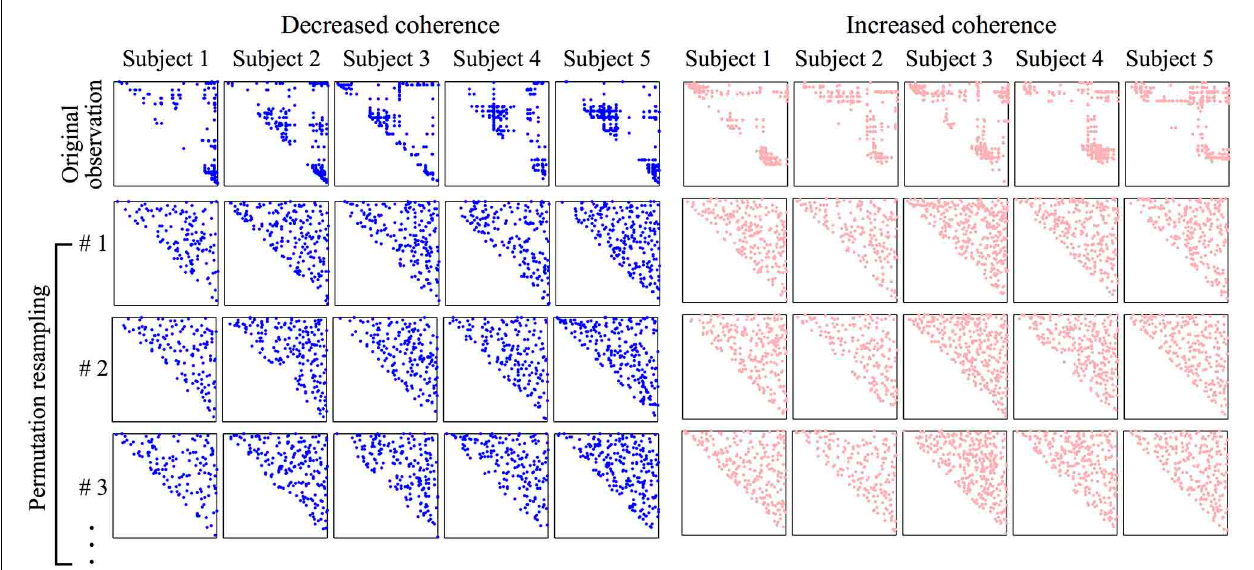
FIGURE 7 | Coherence matrices showing spatial distribution of electrode-pairs with significant wake vs. coma coherence difference. The coherence matrix is diagonally symmetric, we need only display its upper half. The first row of the left panel corresponds to the first row of Figure 6 ; the first row of the right panel corresponds to the second row of Figure 6 . The marked (either in blue or pink) dots in the matrix are the top 5% most changed (decreased: blue; increased: pink) phase-coherence during transit from wake to coma. The row and column indices of a marked dot identify a pair of electrodes shown in Figure 6 . To test the